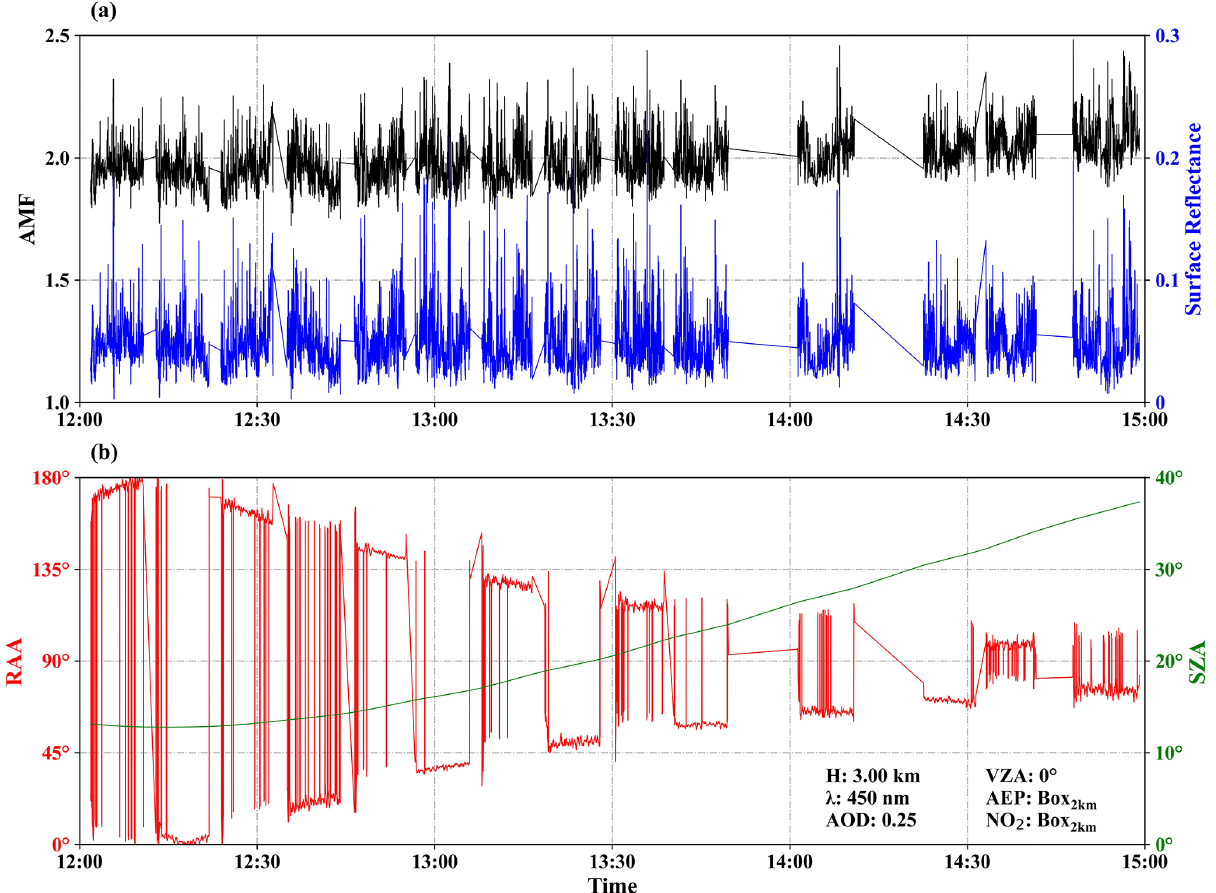
Figure 7. Time series of NO 2 AMF compared with (a) surface reflectance; (b) SZA and RAA for the research flight on 23 June 2018, computed with SCIATRAN model based on the RTM parameters from the UVHIS instrument. Only data of the nadir observations in each flight line are